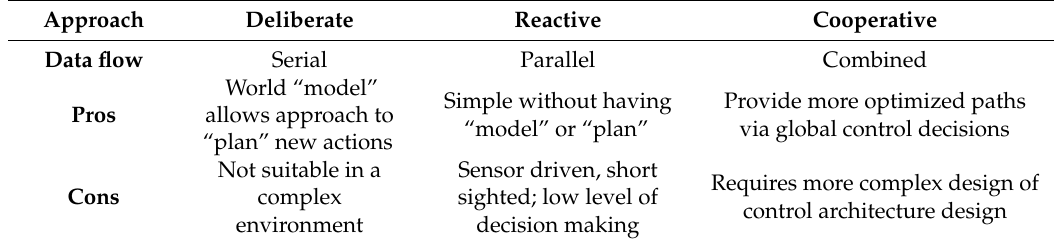
Table 3. Three types of control architectures introduced by Hagen et al.